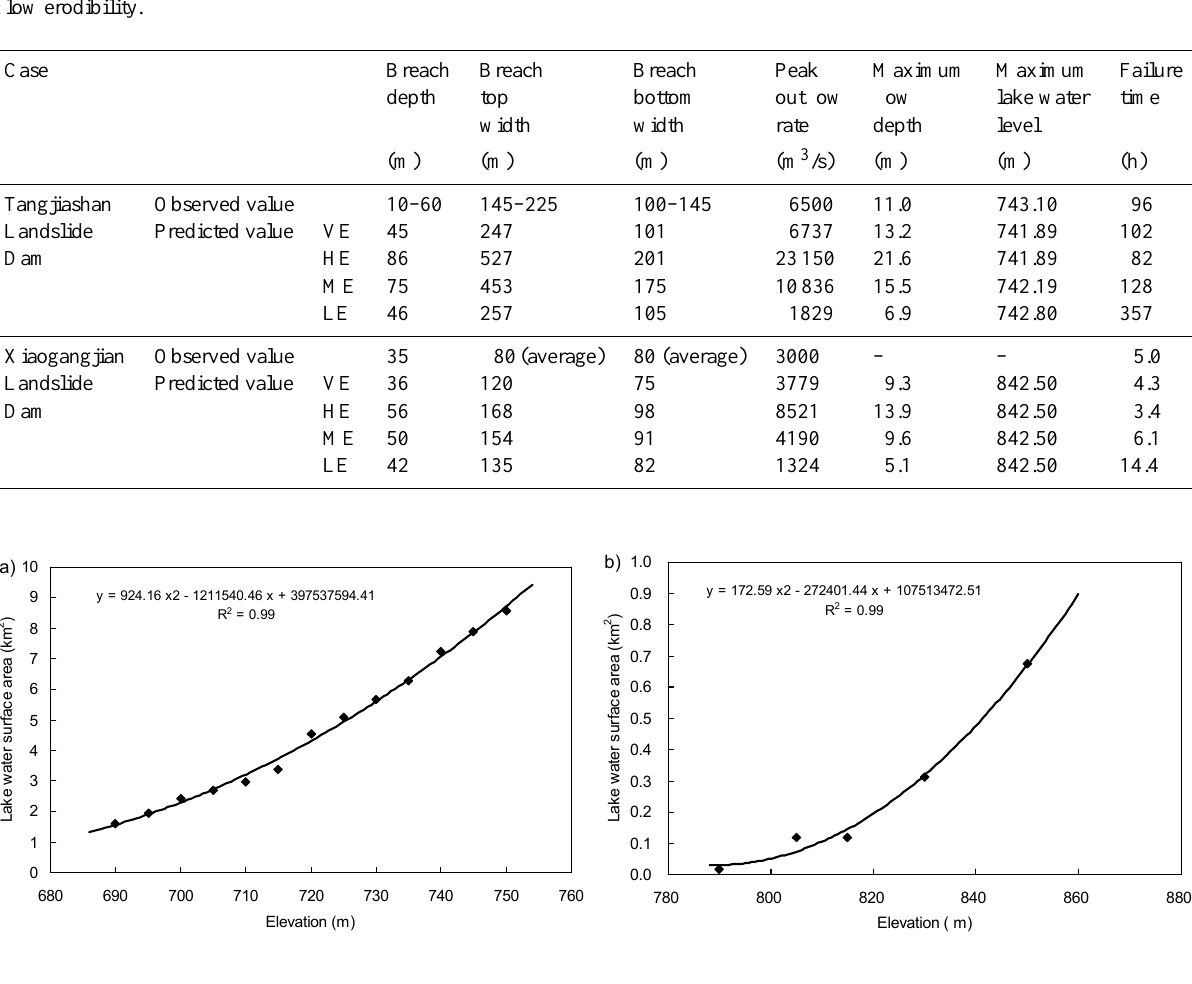
Fig. 8. Relationship between elevation and lake water surface area. ( a ) Tangjiashan Landslide Dam (data from Zhang et al. 2008); ( b ) Xiaogangjian Landslide Dam (data from Liu et al. 2009a).